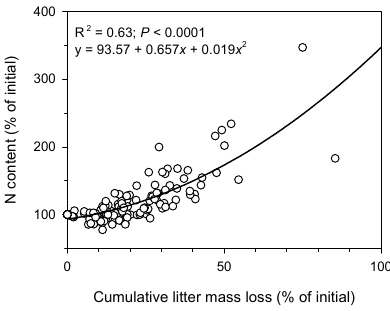
Figure 5. Second-order polynomial relationship between the cumu- lative litter mass loss (in percentage of initial) of leaf litter of Pinus sylvestris (Hyytiälä, Finland), Pinus sylvestris (Männikjärve, Esto- nia), Fagus sylvatica (Sorø, Denmark), and Pseudotsuga menziesii (Speulderbos, Netherlands), Lolium perenne (Easter Bush, UK) and Festuca pseudovina (Bugac, Hungary) and the litter N content rel- ative to initial during a reciprocal litter transplantation decompo- sition experiment. Data points ( n = 136) are the average value of three replicate litter